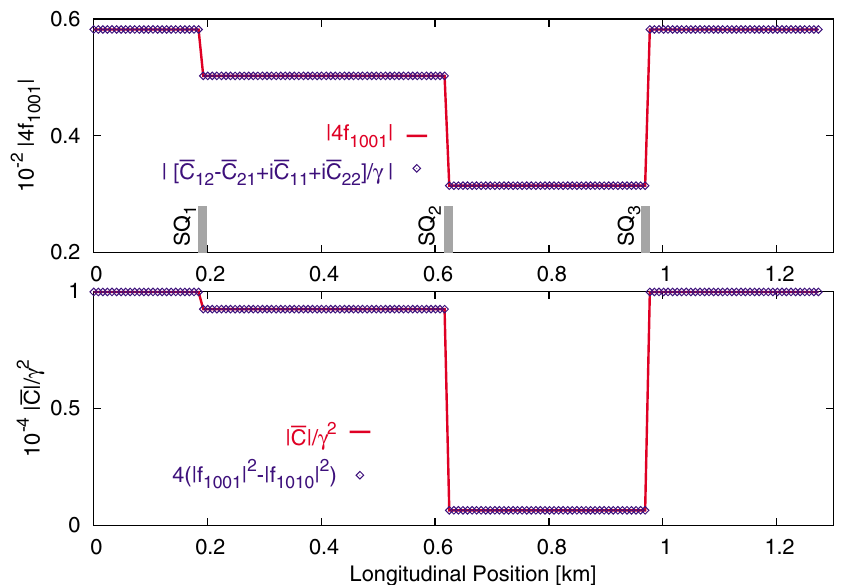
j and j(cid:11)(cid:6) C (cid:2) C (cid:7) (cid:5) i (cid:6) C (cid:5) C (cid:7)(cid:12) =(cid:20) j plotted as a function of the longitudinal position. Bottom: j C j =(cid:20) 2 FIG. 1. (Color) Top: 4 j f 1001 12 21 11 22 j 2 (cid:2) j f j 2 (cid:7) plotted as a function of longitudinal position. Horizontal and vertical tunes are Q and 4 (cid:6)j f 1001 1010 17 : 257 , respectively.